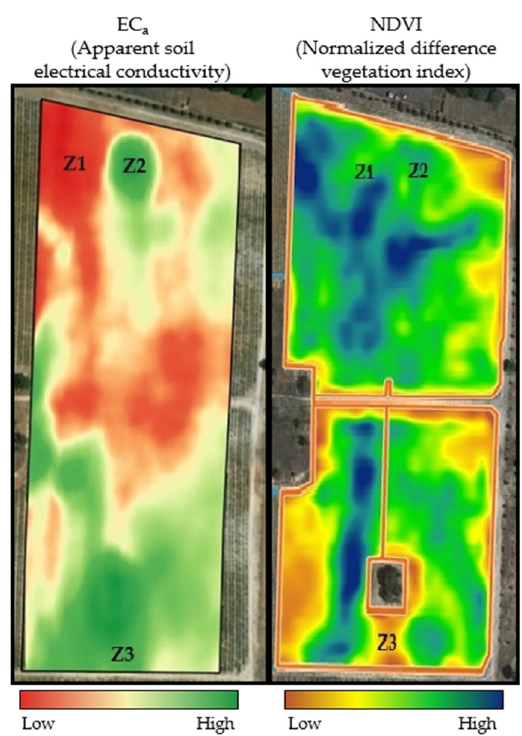
Figure 2. Satellite image of the study area (6.77 ha), with EC a and NDVI maps and the respective legend. In the figure, it is also possible to view the three delineated zones (Z1, Z2, and Z3 as mentioned in [30]).